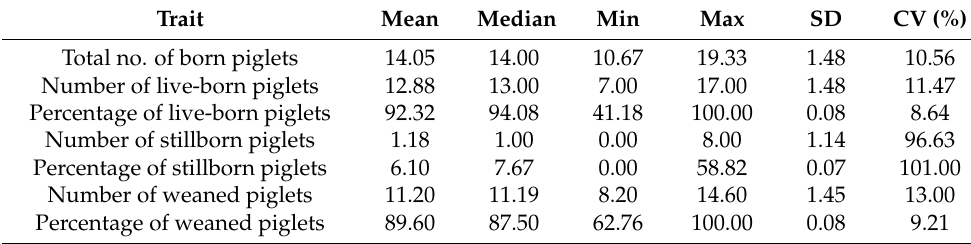
Table 3. Summary statistics of the traits related to litter size in the sows analyzed, across both breeds studied.